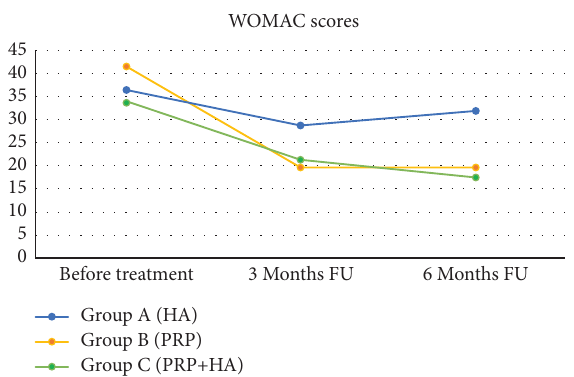
Figure 2: Te evolution of the mean Western Ontario McMaster Universities Osteoarthritis Index (WOMAC) scores in the three groups. HA: hyaluronic acid, PRP: platelet-rich plasma, and FU: